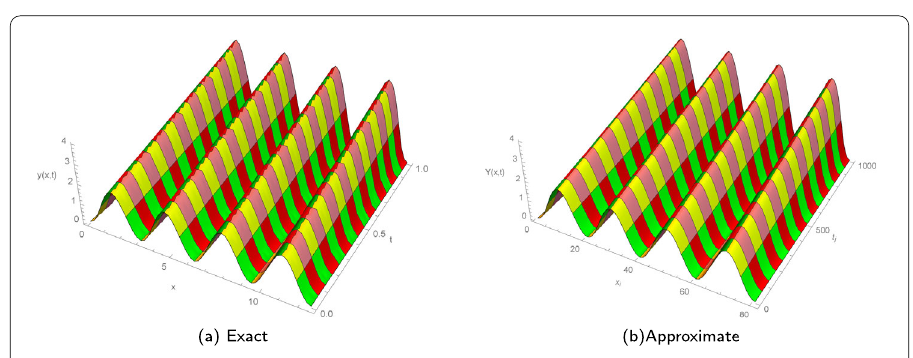
Figure 2 Exact and numerical solution for Problem 1 with N = 80, (cid:2) t = 0.001, and α = 1.50